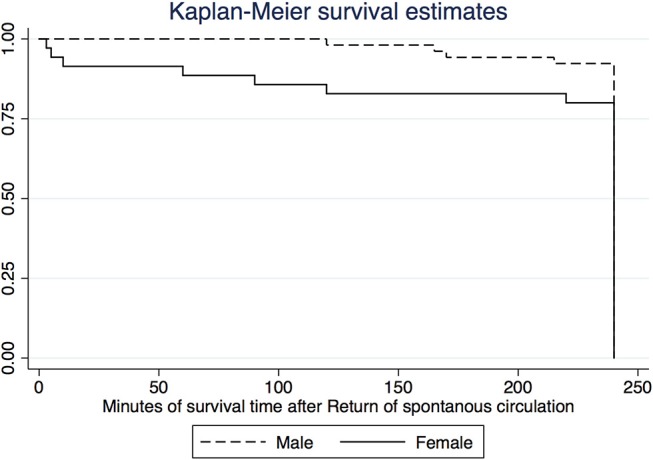
Kaplan-Meier survival curve.